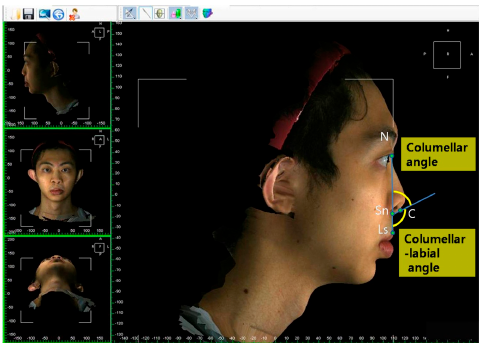
Figure 3. Representation of columellar angle and columellar-labial angle measurements. Changes or differences in these parameters are associated with cephalic or caudal rotation of the nasal tip.